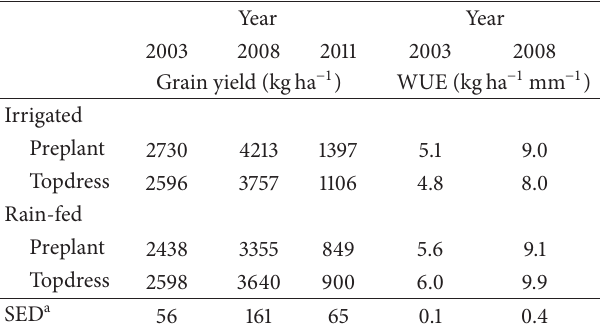
Figure 1: Rainfall distribution for Altus, Oklahoma, area from the average time of preplant irrigation to the average time of grain harvest for years analyzed. Data obtained from the Oklahoma Mesonet climate monitoring station [31]. Table 4: Grain yield and water use efficiency (WUE) interaction means by year for plots that received either irrigation or were rain-fed and received their total N fertilizer preplant or topdressed